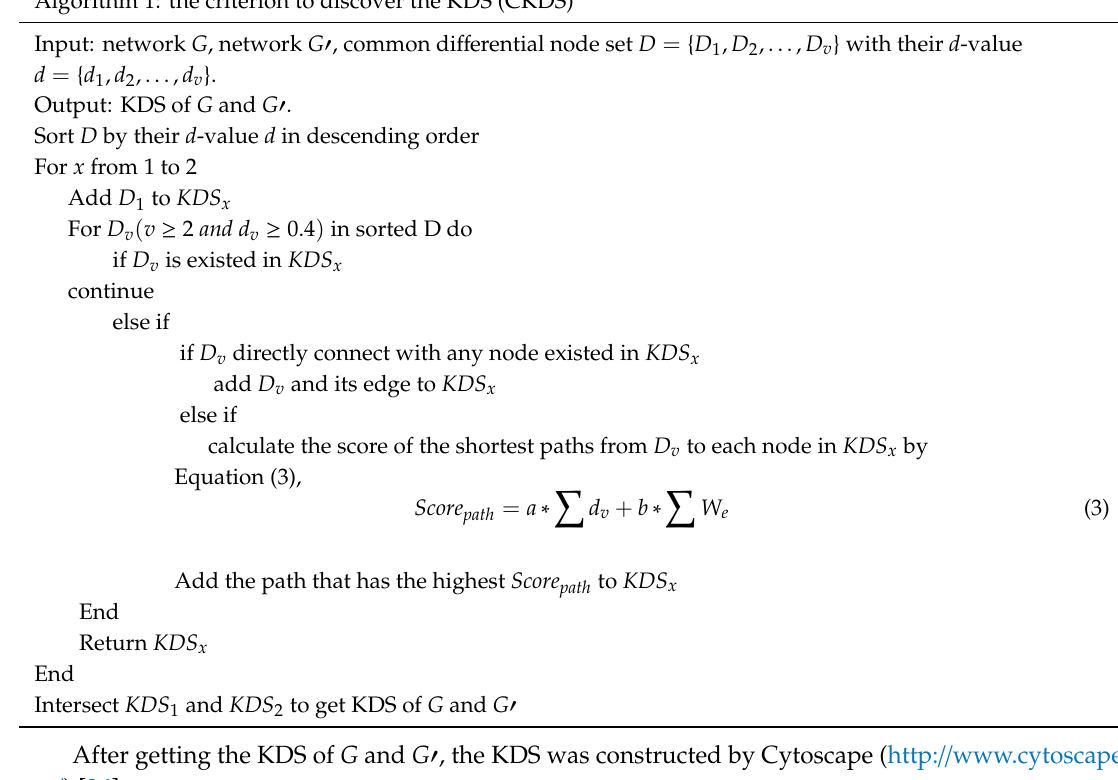
Algorithm 1: the criterion to discover the KDS